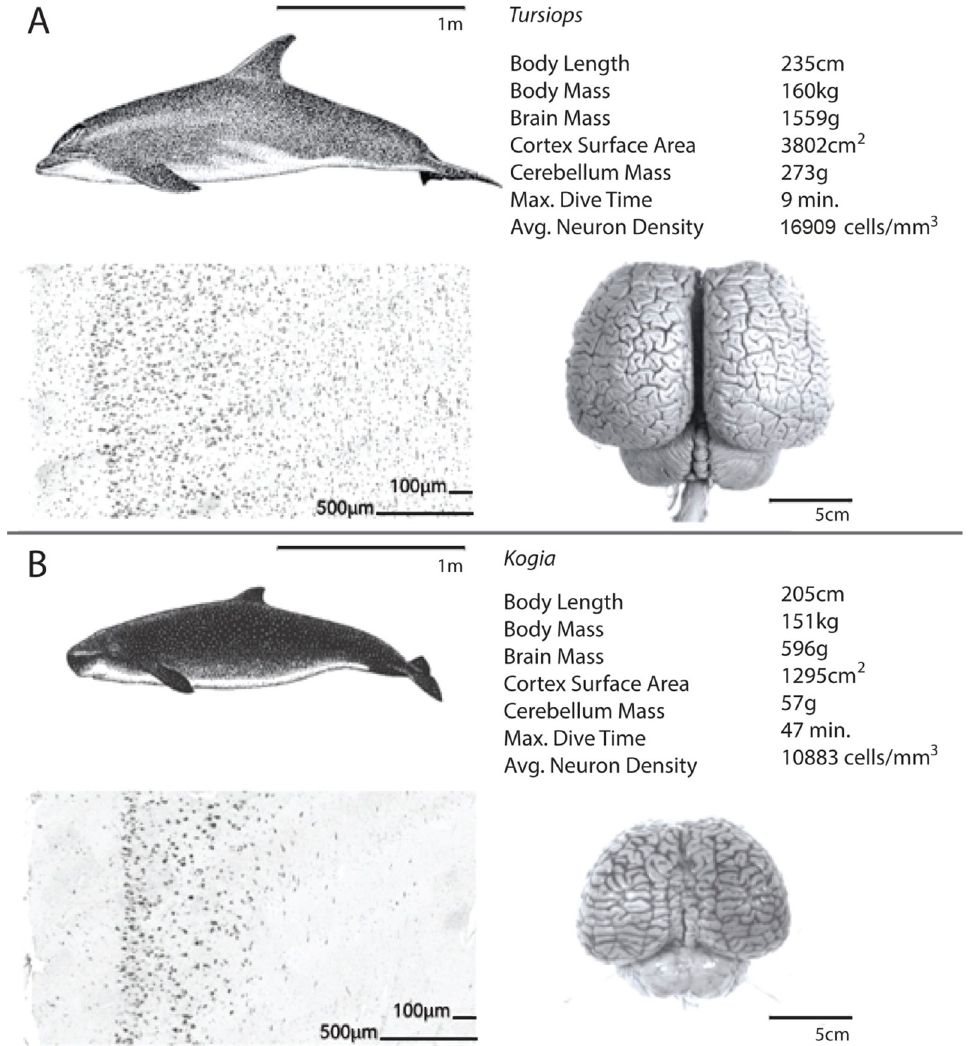
Fig 3. Comparison of a smaller short diver and a smaller long diver. An illustration of the differences in brain mass, cortical surface area, cerebellum mass, average neuron density, and maximum dive time between one female adult delphinid ( Tursiops truncatus ; A) and one female subadult individual from the family Kogiidae ( Kogia breviceps ; B) of similar body size.